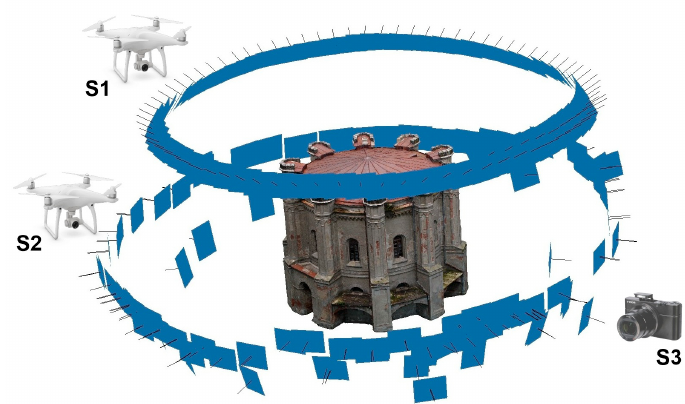
Figure 5. Photos taken using the DJI and Sony cameras.